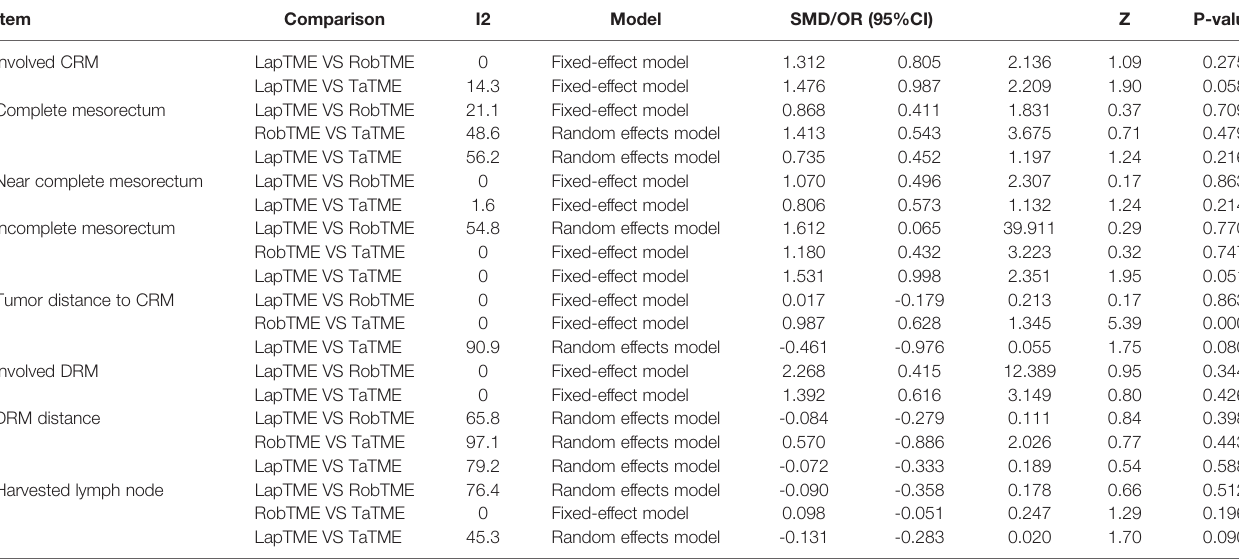
TABLE 4 | Results of traditional pair-wise meta-analysis. Item Involved